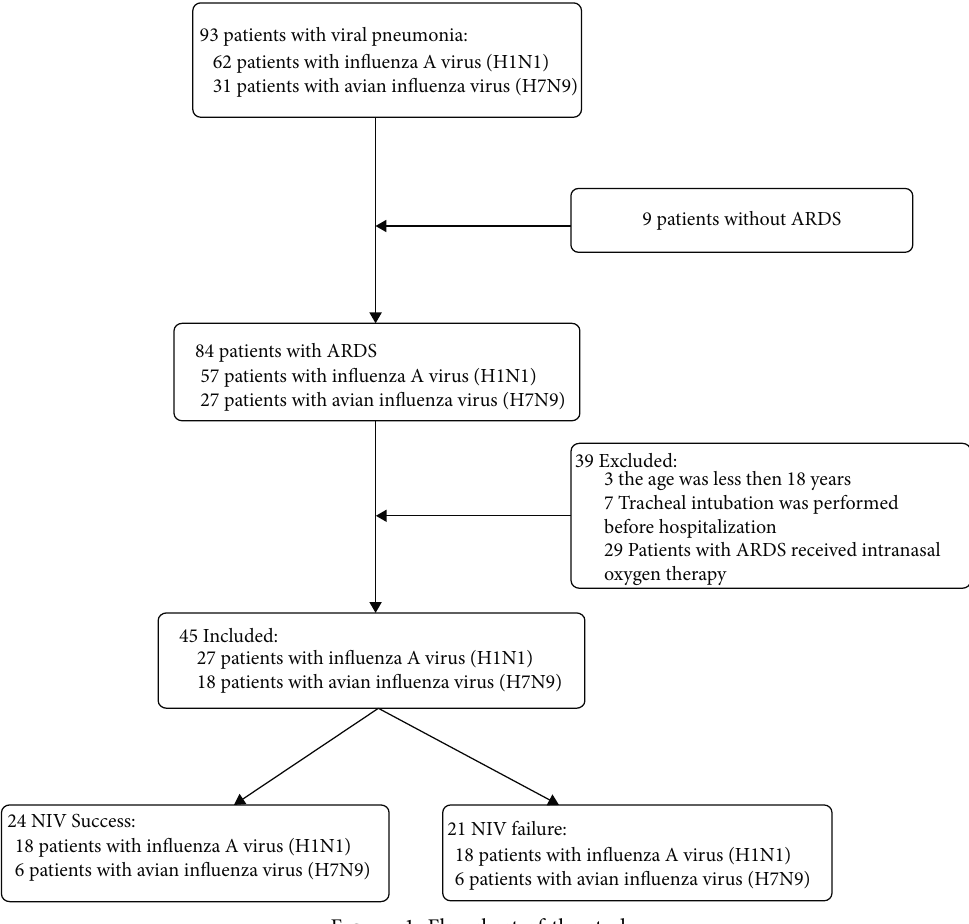
Figure 1: Flowchart of the study. Table 1: Demographic and clinical characteristics of 45 patients with infuenza A-associated acute respiratory distress syndrome.